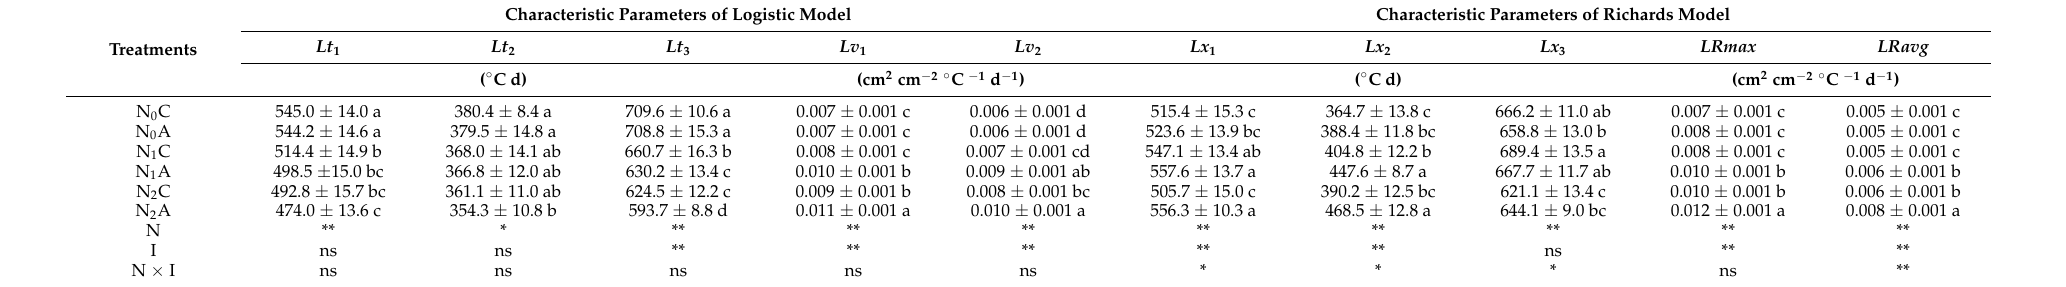
Table 3. Characteristic parameters describing LAI process of tomato under different